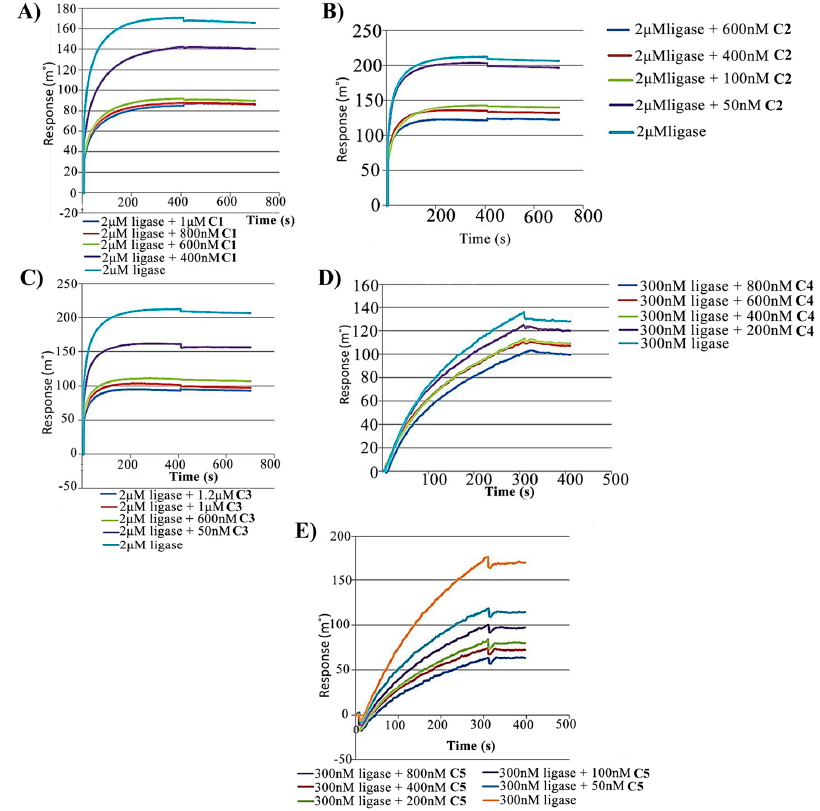
Figure 1. SPR sensorgram. SPR sensorgram showing surface competition assay between HpDNA ligase and the small molecules. A qualitative analysis of the in vitro competition between DNA ligase and small molecules (present in solution) for binding to Hp β -clamp (immobilized on the chip surface) was carried out. For the small molecules ( A ) 5-chloroisatin (C1); ( B ) 6-nitroindazole (C2) and ( C ) (S)-carprofen (C3), a mass of ~6 ng of Hp β -clamp gets immobilized on the chip surface while for ( D ) 5-nitroindole (C4) and ( E ) 3,4-difluorobenzamide (C5), a mass of ~4 ng of Hp β -clamp gets immobilized on the chip surface. The concentration of ligase was kept the same throughout each experiment with a small molecule. As the concentration of the small molecule was increased, the SPR response decreased.